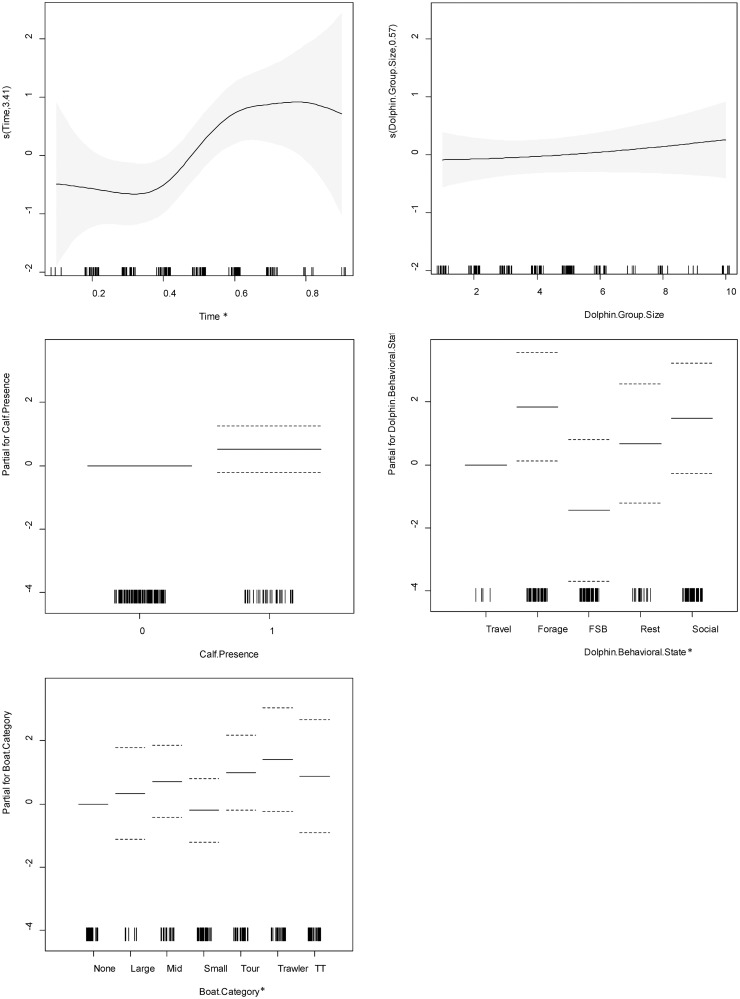
Charts for the partial contribution of individual explanatory variables in the fitted GAM for reorientation rate.Includes A) time of day, B) dolphin group size, C) calf presence, D) dolphin behavioral state, and E) vessel category. The rugplot along the x-axis indicates the number of observations for each factor. The gray shading for smooth terms, and the dotted lines for linear terms, indicate the 95% confidence intervals. On the y-axis, values >0 indicate a positive correlation with reorientation rate, values <0 indicate a negative correlation, and a value of 0 indicates no effect. An asterisk (*) indicates a variable with a statistically significant effect at alpha level 0.05. A closed circle (•) indicates a variable with a statistically significant effect at alpha level 0.1.